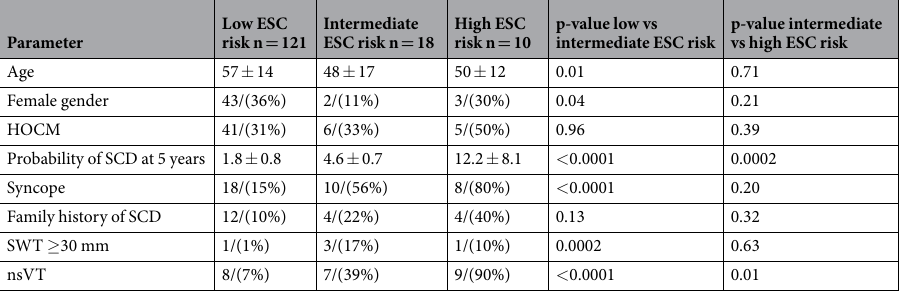
Table 1. Clinical characteristics and traditional risk factors according to ESC risk scores. Data are presented as ± standard deviation. Abbreviations: HOCM: hypertrophic obstractive cardiomyopathy, nsVT:non-sustained ventricular tachycardia, SCD:sudden cardiac death, SWT:septal wall